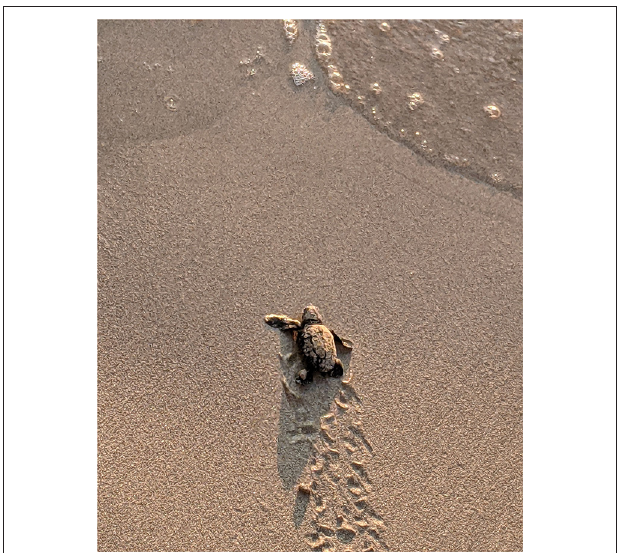
FIGURE 5 | Loggerhead hatchling heading for Mediterranean, Kephalonia,